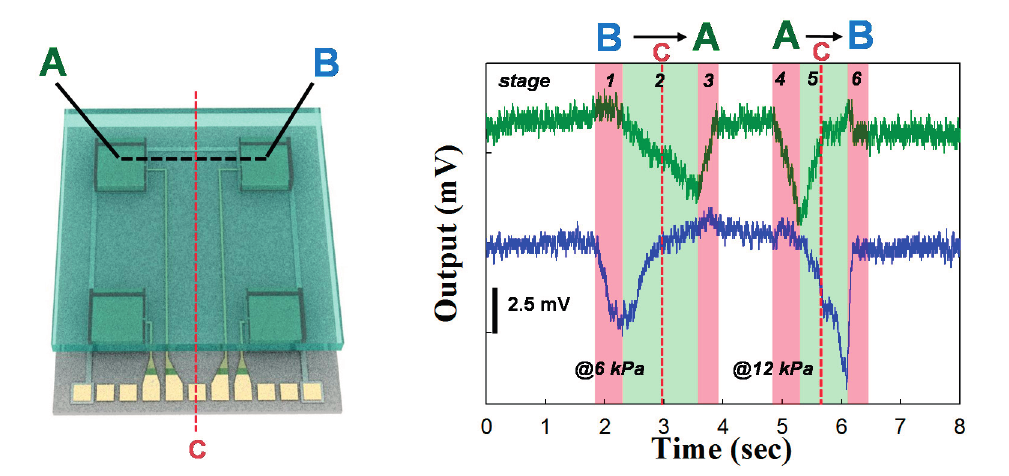
Figure 6. Tangential force electrical output signal when the objects sweep between the A and B sensor